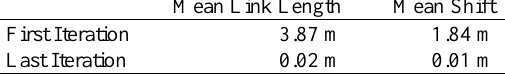
Table 4. Results for first and last iteration step for the adjustment for (test case 2)